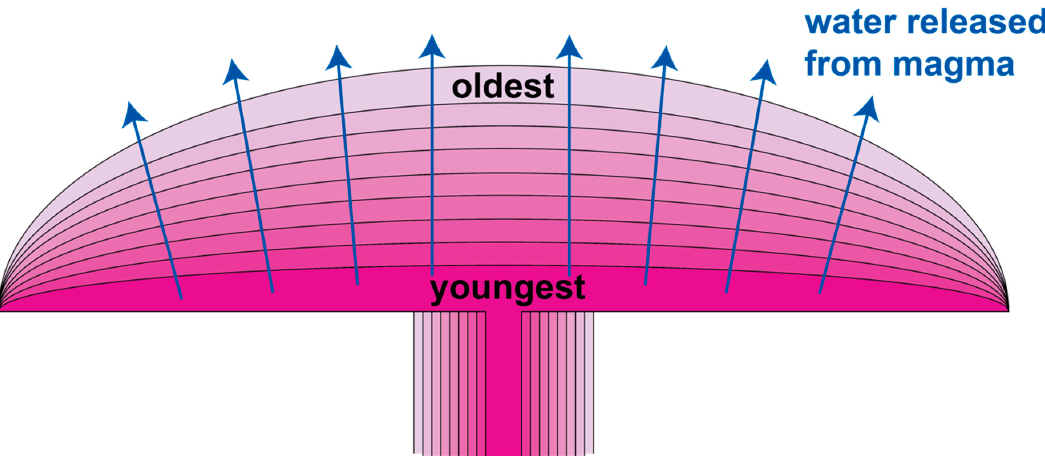
Figure 1. Schematic diagram illustrating incremental pluton growth by downward stacking of intrusive increments. Space for each increment is made by opening of a subhorizontal crack and accommodated by some combination of roof uplift and floor subsidence. Arrows represent migrating water released by crystallization. Buoyancy will cause much of the water to ascend through overlying older increments but migration paths will be strongly affected by the spatial pattern of permeability.